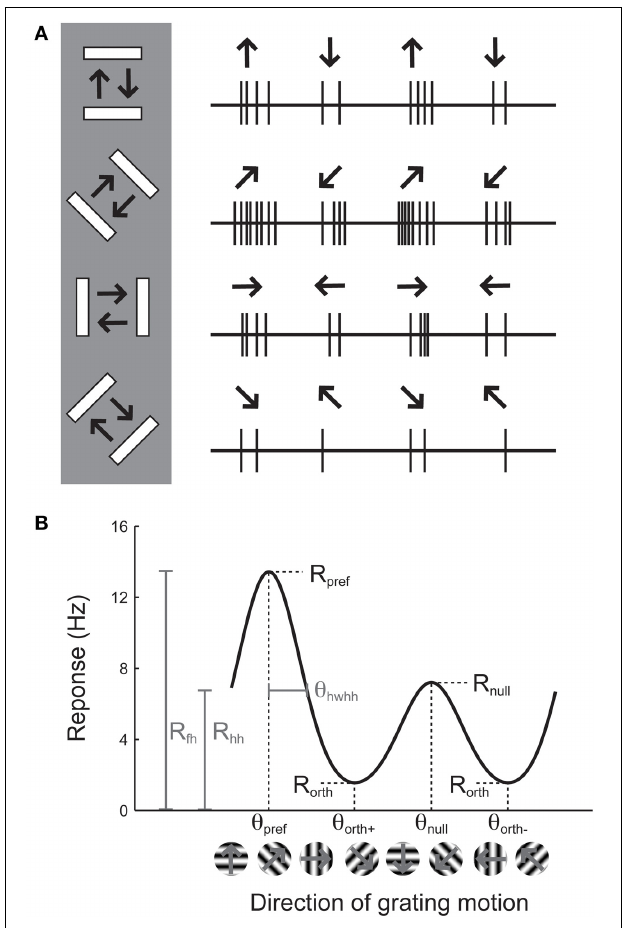
FIGURE 1 | Illustration of the assessment of orientation and direction selectivity. (A) Left: Depiction of a bar stimulus moving at different orientations across the receptive field of an example cell. The cell’s responses to each orientation are indicated at the right. The preferred orientation is 45 ◦ . During each presentation of the bar stimulus, the stimulus moves back and forth in two opposite directions. This cell responds more strongly to movement of the bar toward 45 ◦ than it does to the opposite direction (225 ◦ ). (B) A graph of responses to the same cell to sinusoidal gratings drifting in several directions. The cell gives the largest response ( R pref ) to 45 ◦ ( θ pref ), and a weaker response ( R null ) to the opposite direction 225 ◦ ( θ null ). The cell responds less strongly to stimulation at either of the two orthogonal orientations ( θ orth + and θ orth + ). The cell’s response decreases as the direction of the stimulus deviates from θ pref ; the difference between θ pref and the angle that causes the response to drop to half ( R hh ) its maximum value is called the half width at half height ( θ hwhh ).